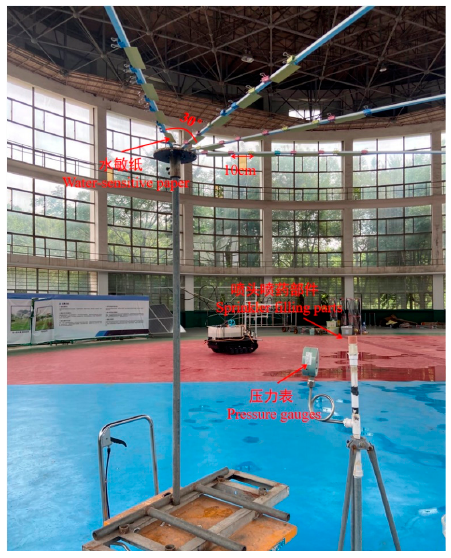
Figure 5. Layout of spraying pesticide performance.